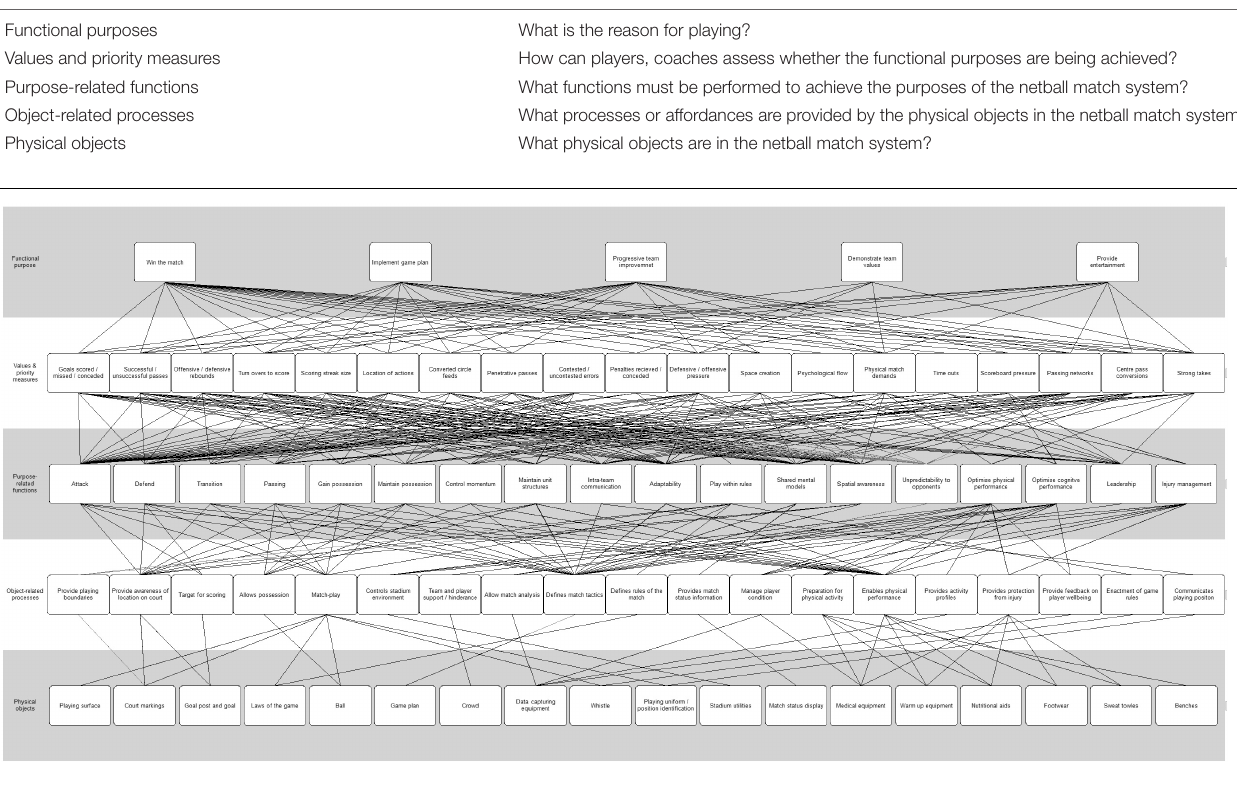
FIGURE 1 | The work domain analysis of the netball performance